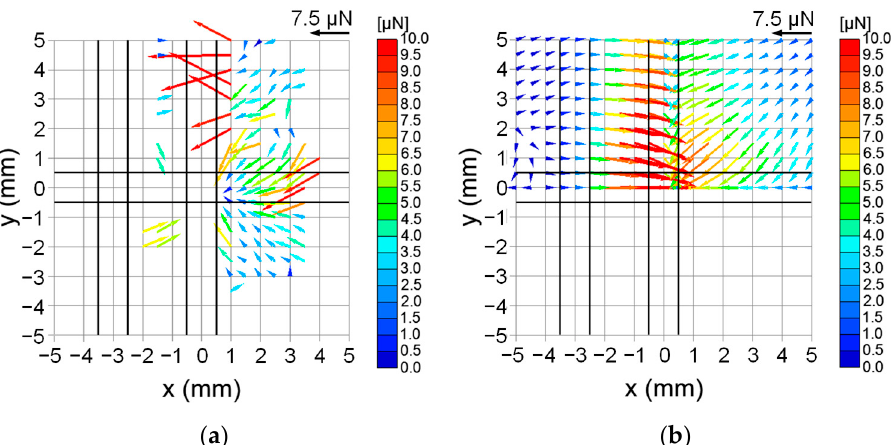
Figure 15. Comparison of electrostatic forces between the experimental and the simulation for the cases where the upper electrode of the initial point is grounded: ( a ) Experimental (four times magnified version of Figure 14a with arrows at x = − 1 mm hidden); ( b ) Simulation.